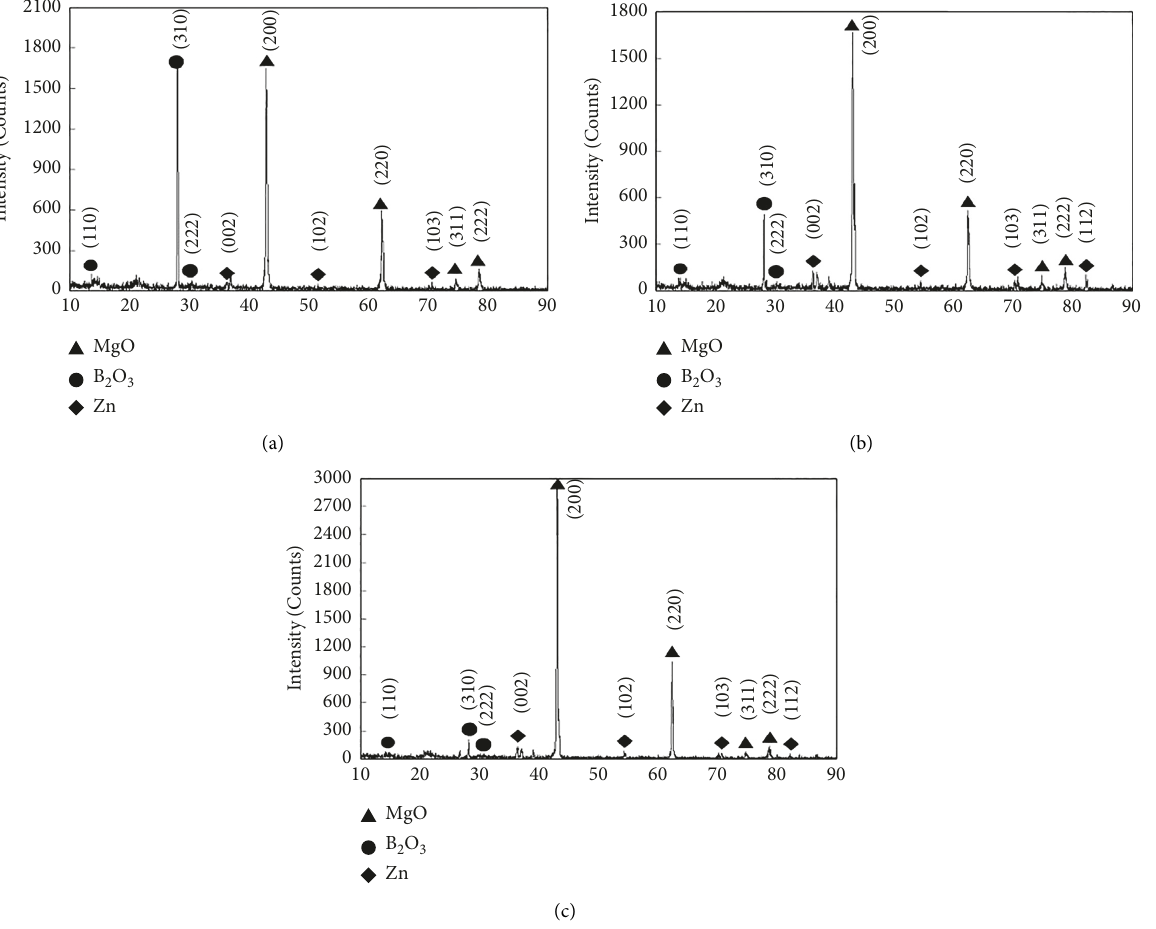
Figure 3: XRD composition analysis of coating (B). (a) B1. (b) B2. (c) B3.